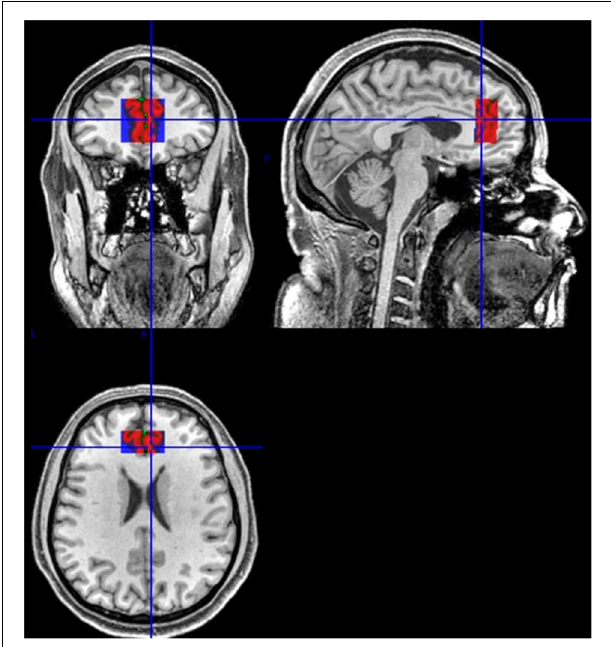
FIGURE 1 | Example of the anatomical reference for the position of the volume of interest (VOI). Sagittal, coronal, and axial